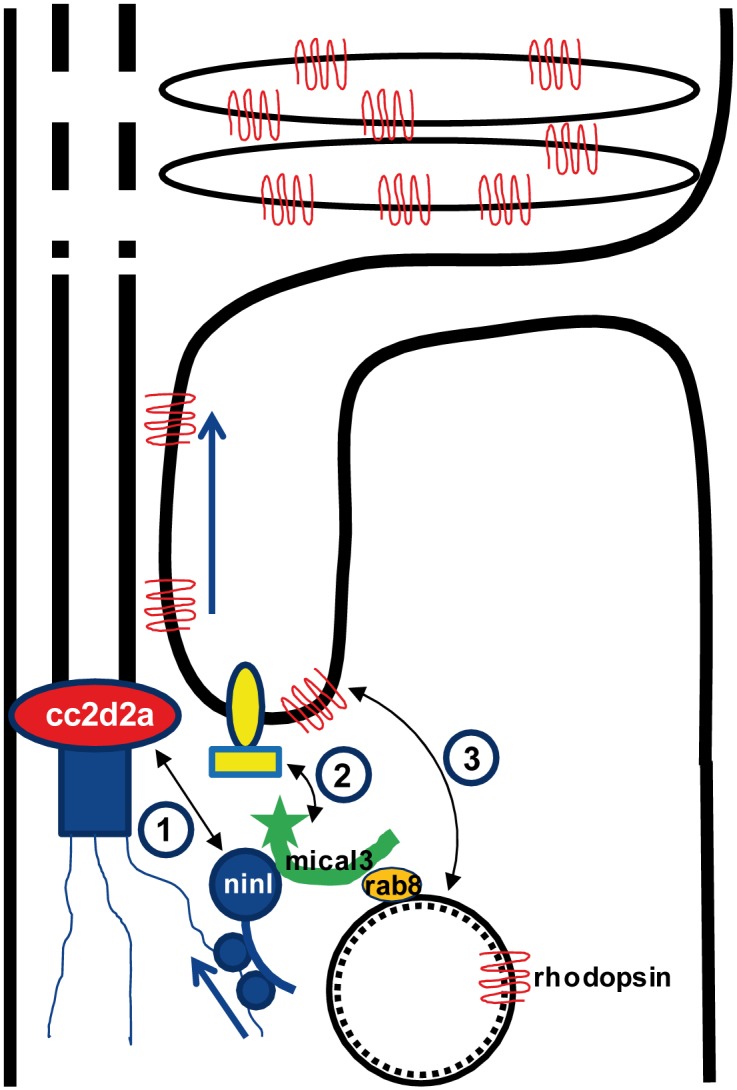
Proposed model for CC2D2A and NINL function in trafficking, docking and fusion of rhodopsin-carrier vesicles.1) CC2D2A binds NINL and thus provides a docking point at the base of the connecting cilium for incoming vesicles. 2) NINL binds MICAL3 which in turn binds RAB8 that is coating the rhodopsin-carrier vesicles. Since NINL also associates with the cytoplasmic dynein1 motor complex, it provides a link between the carrier vesicles and the motor generating the movement along the microtubules. 3). MICAL3 subsequently interacts with ELKS and its redox activity promotes remodeling of the docking complex resulting in fusion of the vesicle at the periciliary region.